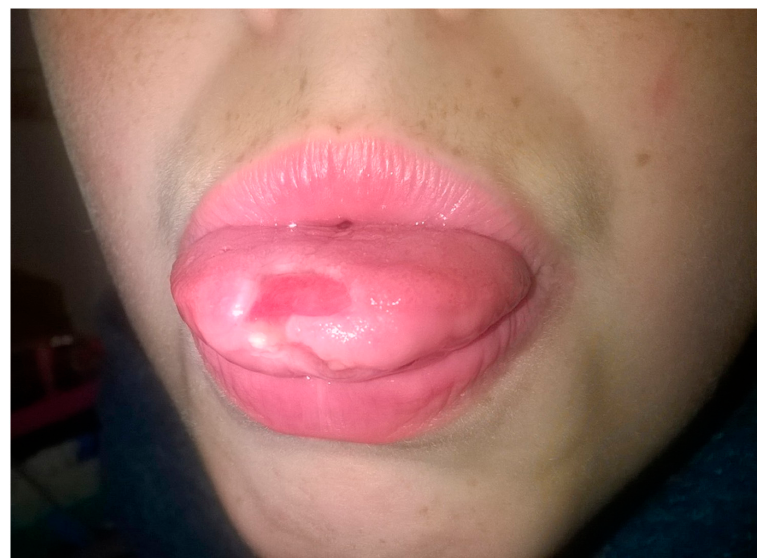
Figure 5. Aphthous lesion on the tip of the tongue, on the upper side.